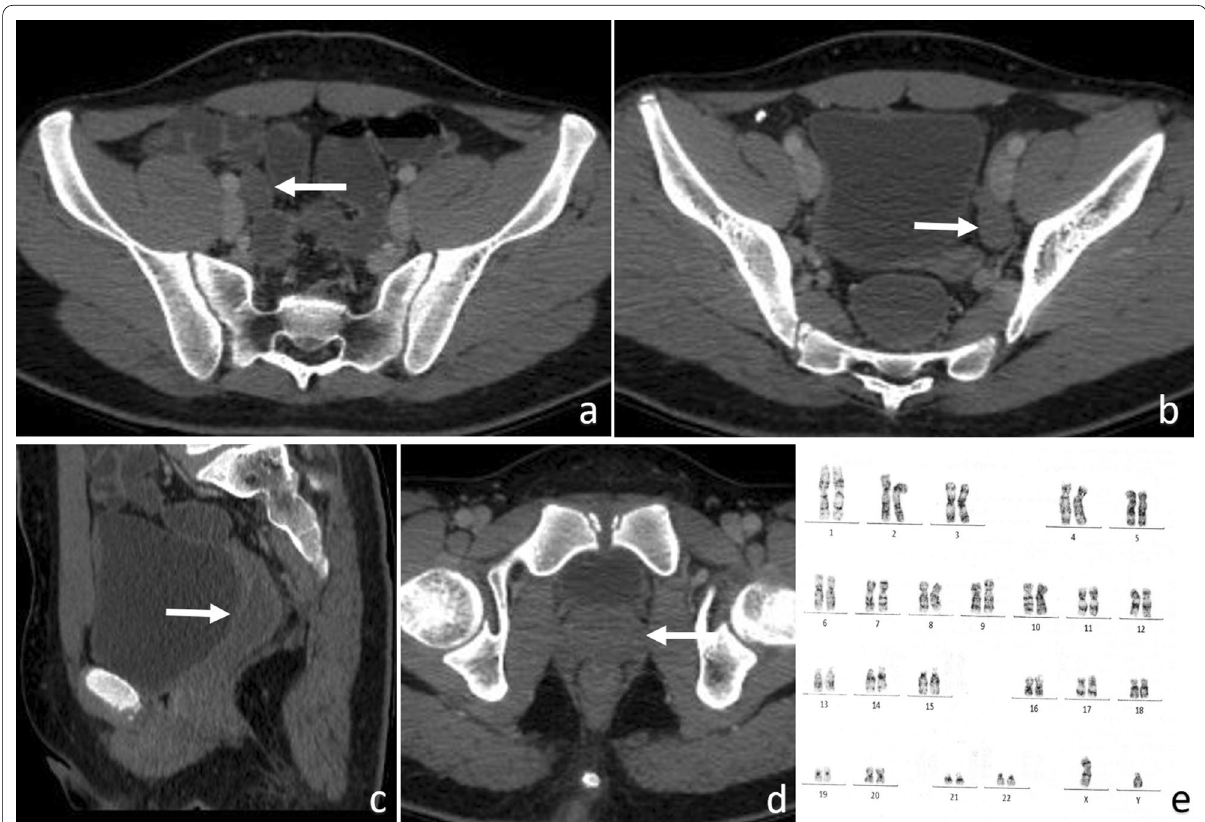
Fig. 1 Shows bilateral ovoid homogeneous structures—the testes in iliac fossae (arrows in a , b ); A uterus-like structure seen posterior to the bladder (arrow in c ); d -normal prostate; e - normal